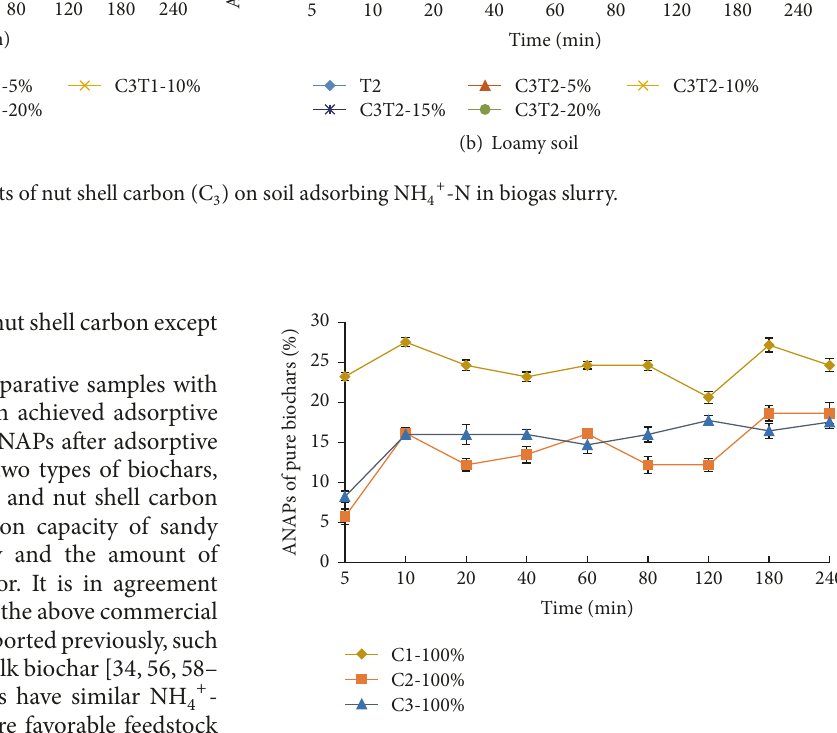
Figure 6: Comparison of different biochars adsorbing NH 4+ -N in biogas